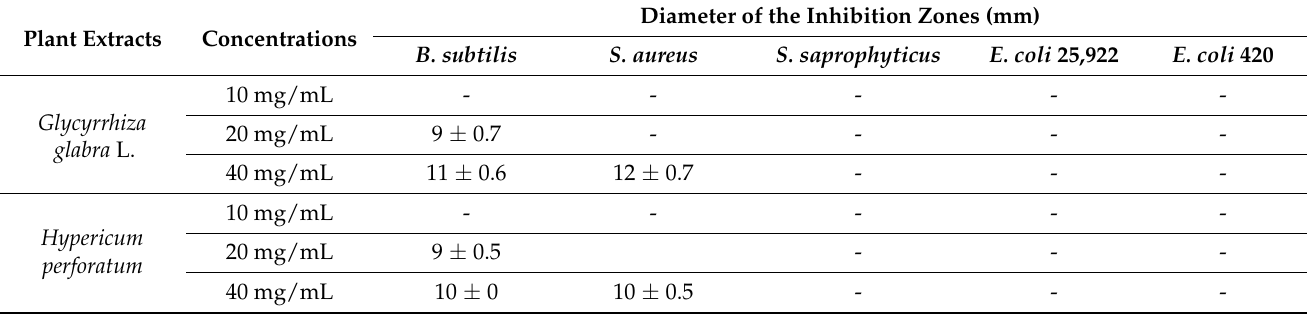
Figure 1. Determination of the anti-microbial activity of theextracts from G. glabra ( A , C ) and H. perforatum ( B , D ) against Bacillus subtilis 168 ( A , B ) and Staphylococcus aureus 29,213 ( C , D ). The results were obtained by the application of 40 mg/mL water–ethanol extracts using the disc diffusion method. Positive control: Gentamicin discs–15 µg/mL, ( B , D ). All experiments were repeated three times, and similar results were obtained. Table 1. Inhibition zone testing (mm) of the examined plant extracts against Gram-positive and Gram-negative bacterial strains.